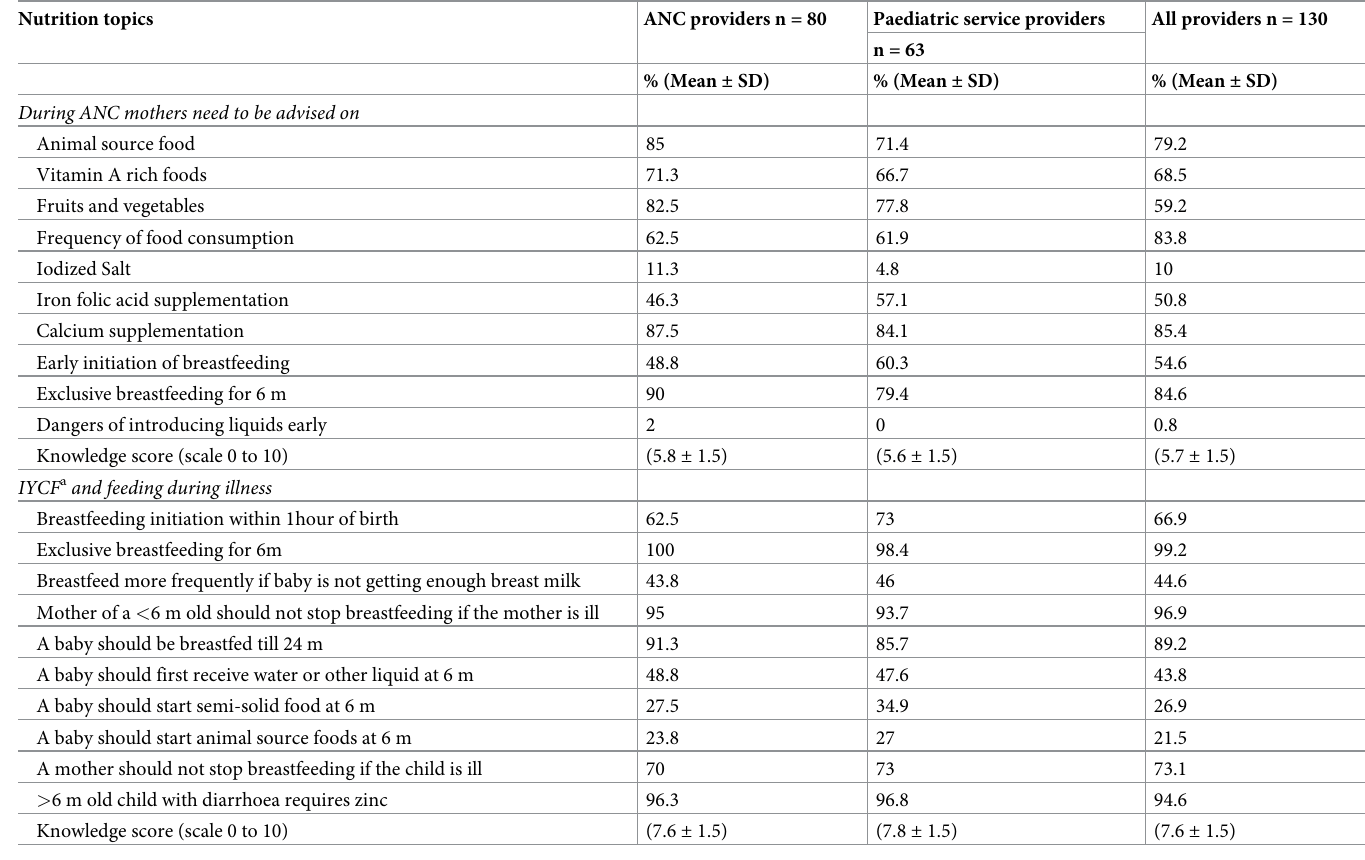
Table 5. Healthcare provider’s knowledge on nutrition topics for counselling pregnant and lactating